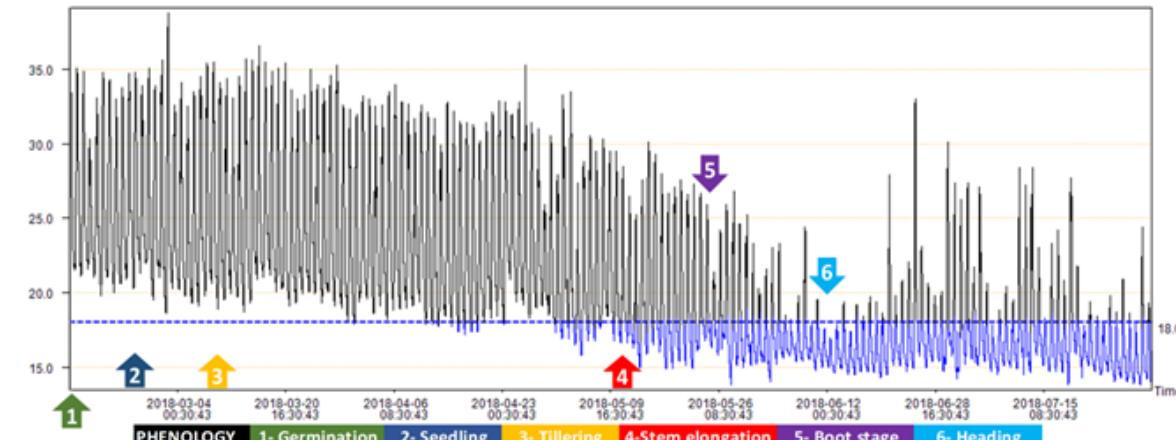
Figure 11 . Environmental temperature’s fluctuation registered during the field stage of the experiment. Graphic was generated using the Elitech termohigrometer’s